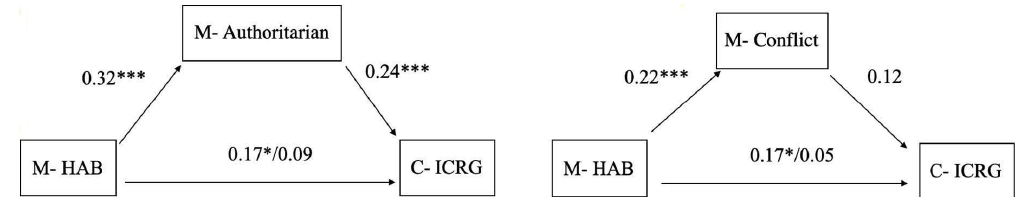
Figure 4. Mother’s authoritarian parenting style ( a ) and mother’s perception of conflict ( b ) mediate associations between mother’s hostile attribution and child’s competence generation response.